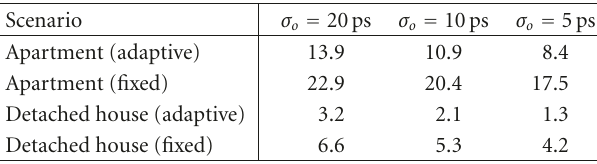
Table 1: Average bit-rate loss (%) in each scenario when the opti- mum loop bandwidth (on average) is employed in all the